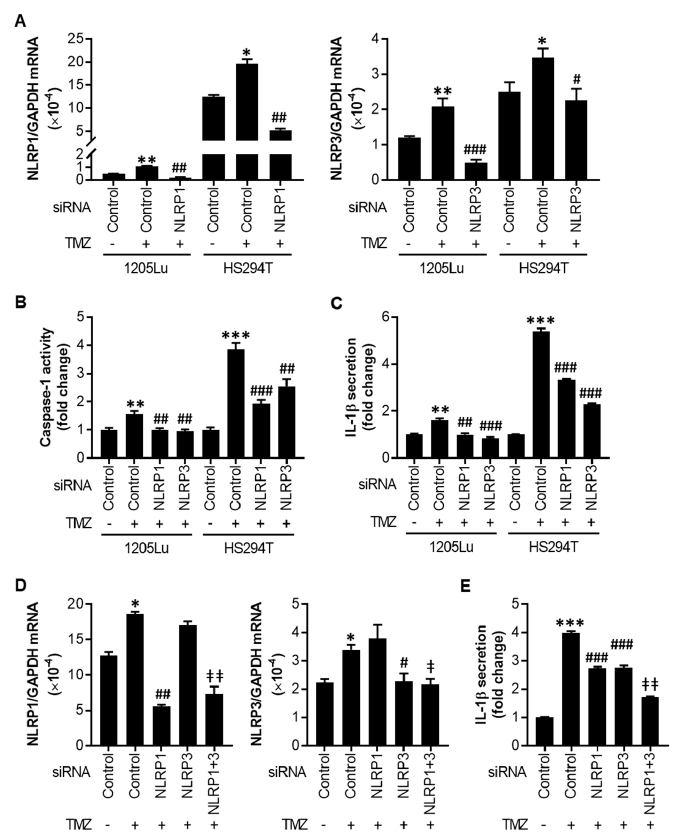
Figure 3. Effects of NLRP1 and NLRP3 small interfering RNAs (siRNAs) on inflammasome activation. Cells were transfected with siRNA control (siControl), siNLRP1, and/or siNLRP3 (40 nM each) for 18 h,